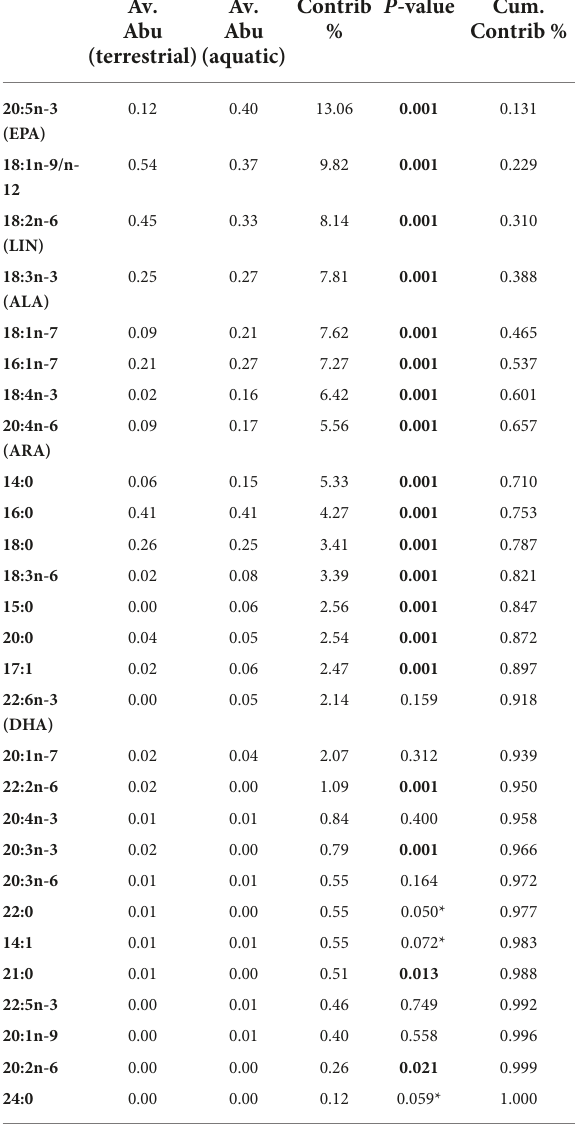
TABLE 1 Similarity percentages (SIMPER) analysis of fatty acid profiles (%) of aquatic and terrestrial insects.